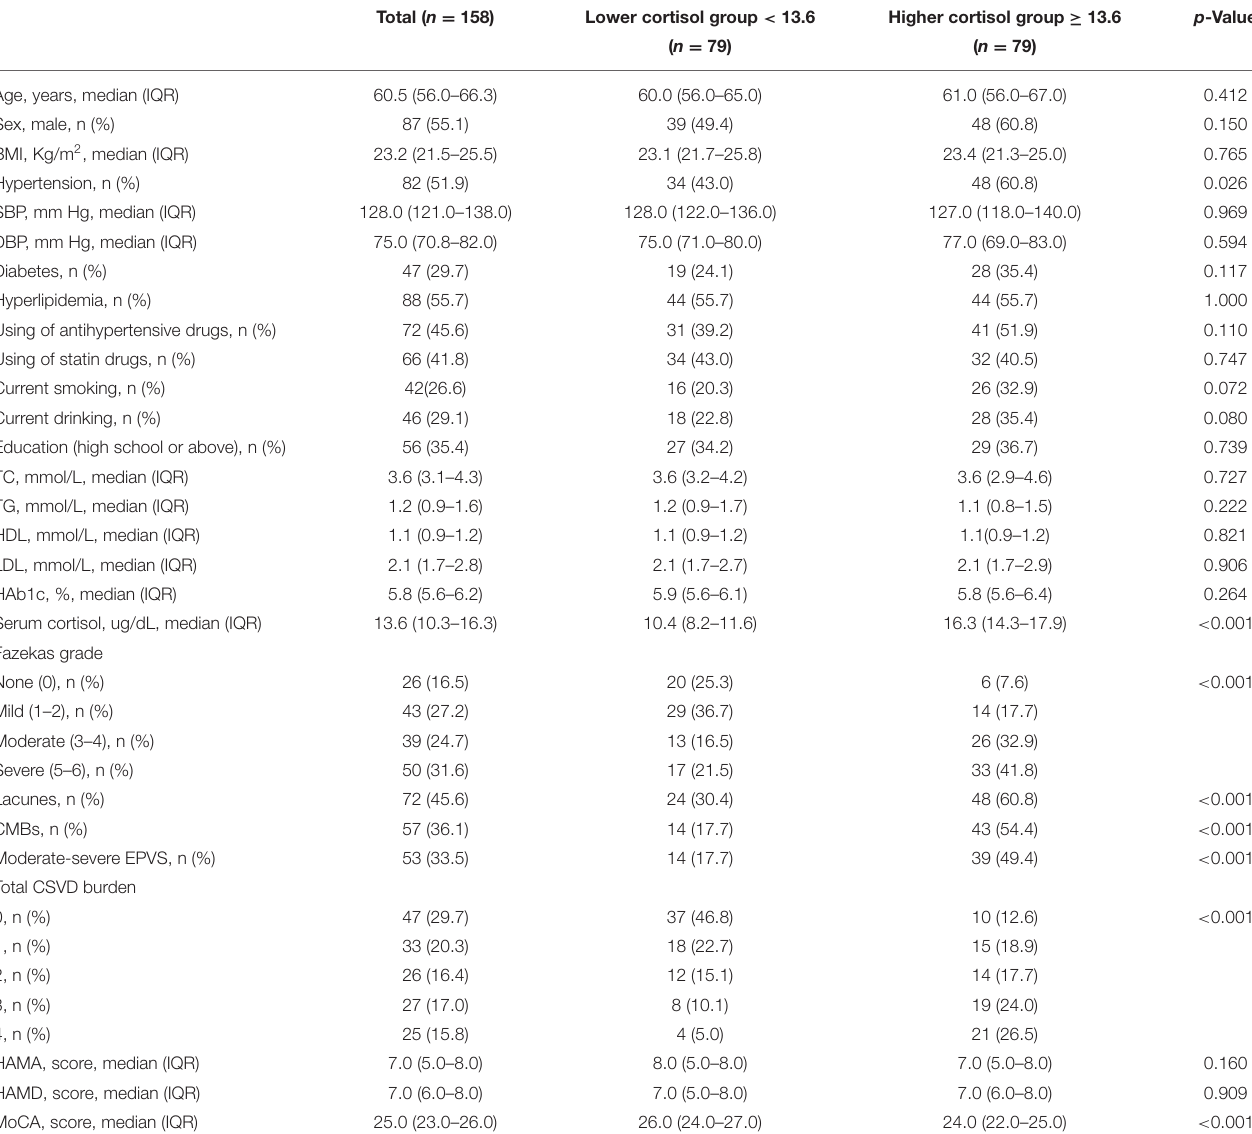
TABLE 1 | Baseline characteristics of study population. Total ( n = 158) Lower cortisol group < 13.6 Higher cortisol group ≥